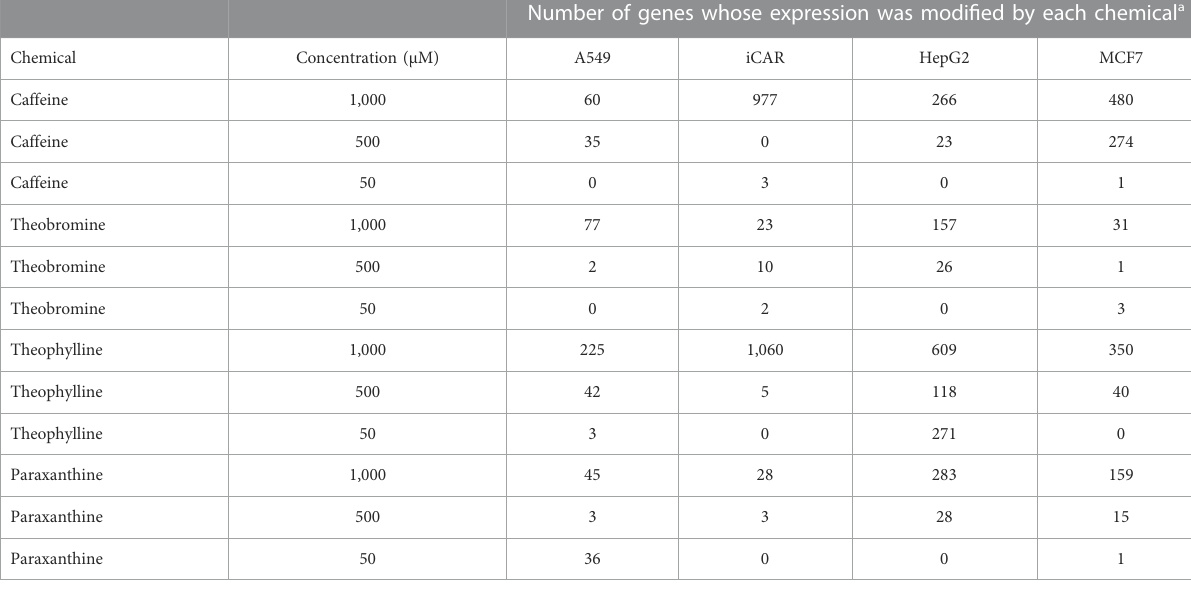
TABLE 3 Number of genes whose expression was signi fi cantly (FDR < 0.05, FC ± 1.2) (CAS# 58 – 08-2), TB (83 – 67-0), TP (CAS# 58 – 55-9) or PX (CAS# 611 – 59-6) in each of the cell types evaluated. Number of genes whose expression was modi fi ed by each chemical